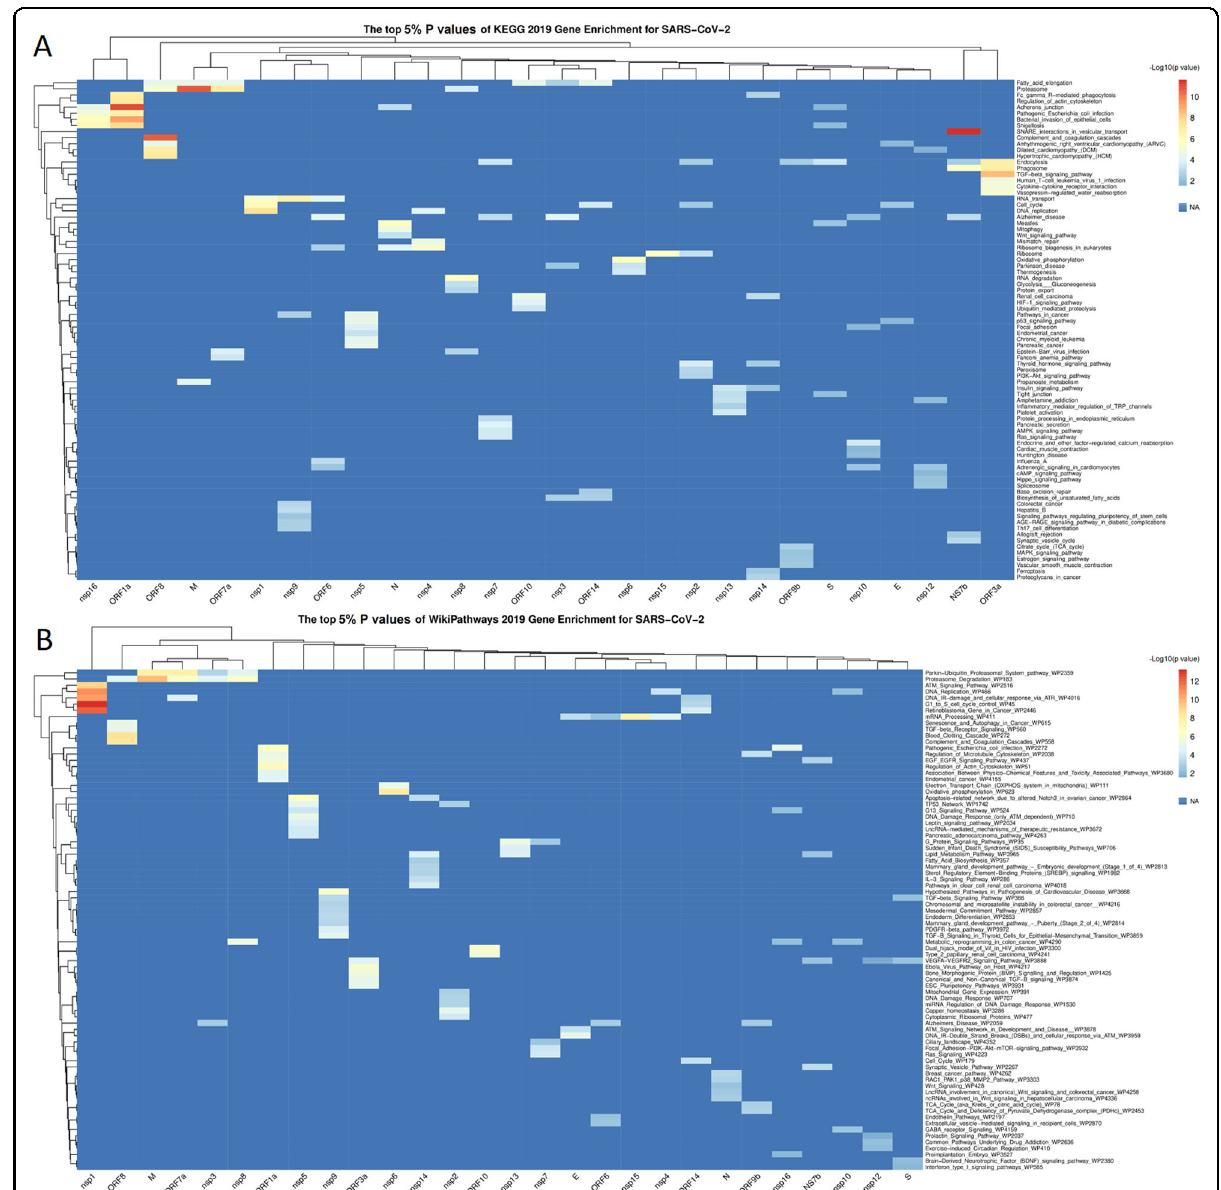
Fig. 3 Heatmap reporting top 5% smallest P values of Gene Enrichment analysis on list of proteins, obtained by every interactome of single viral seed. The values were reported as − Log10 (p value). A P values of Gene Enrichment based on KEGG 2019. B P values of Gene Enrichment based on WikiPathways